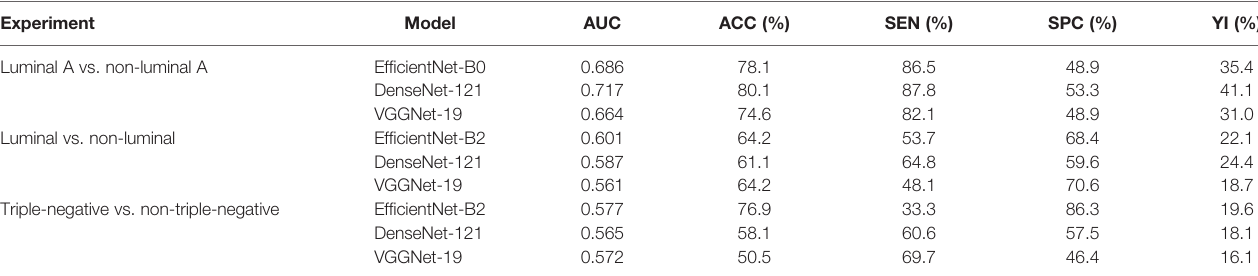
TABLE 2 | Diagnostic performance of deep convolutional neural network model for differentiating breast cancer subtypes in the main cohort.